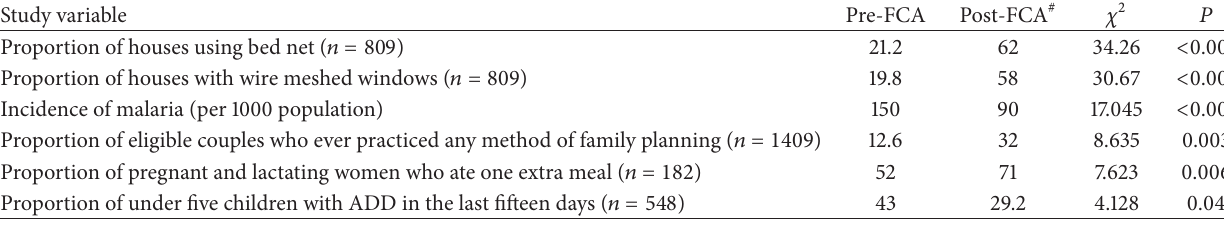
Table 4: Key study variables before and after the implementation of family centered approach (FCA) in the study area. Study variable Proportion of houses using bed net ( 𝑛 = 809 ) Proportion of houses with wire meshed windows ( 𝑛 = 809 ) Incidence of malaria (per 1000 population) Proportion of eligible couples who ever practiced any method of family planning ( 𝑛 = 1409 ) Proportion of pregnant and lactating women who ate one extra meal ( 𝑛 = 182